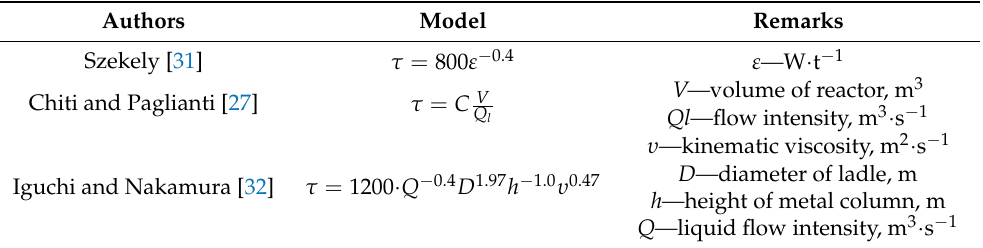
Table 6. Models for calculating mixing